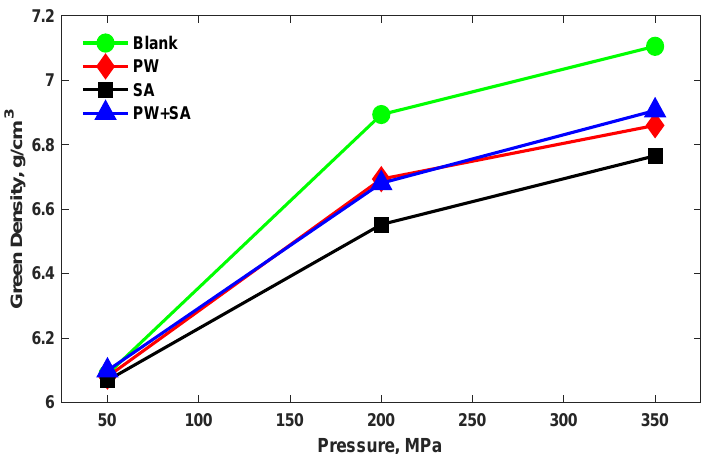
Figure 2. The effects of various compaction pressure levels of the green density of Cu–15Fe green samples with and without different lubrication types.